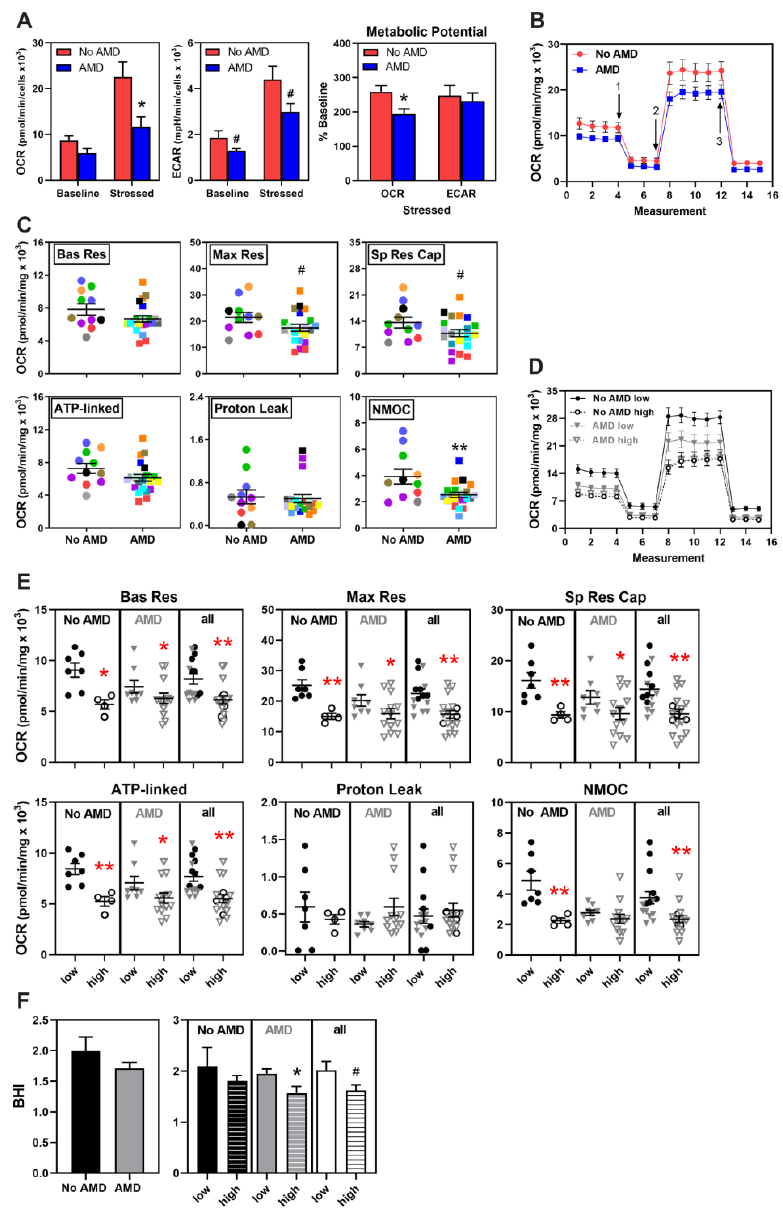
Figure 2. Metabolic dysfunction in AMD and high-risk iPSC-RPE. ( A ) Results from Cell Energy Phenotype Test of iPSC-RPE from No AMD ( n = 4) and AMD ( n = 6) donors shows the baseline and stressed OCR and ECAR. Metabolic Potential (in percent) was calculated from the change in OCR and ECAR. ( B ) Trace from the Cell Mito Stress Test (CMST) of OCR for iPSC-RPE derived from No AMD (8 donors, 11 lines) and AMD (15 donors, 21 lines) donors. Arrows indicate injection of oligomycin (1), FCCP (2), and antimycin A plus rotenone (3). ( C ) Parameters of mitochondrial function were calculated from data shown in B. Lines from the same donor are shown by the matched color symbols. ( D ) Trace from CMST assay showing OCR for iPSC-RPE from CFH low-risk (closed symbols, No AMD 5 donors, 7 lines; AMD 5 donors, 8 lines) and high-risk (open symbols, No AMD 3 donors, 4 lines; AMD 7 donors, 13 lines) donors. ( E ) Parameters of mitochondrial function calculated from data shown in D. Black symbols = No AMD, Grey symbols =AMD. Bas Res = Basal Respiration; Max Res = Maximal Respiration; Sp Res Cap = Spare Respiratory Capacity; ATP-linked = ATP-linked respiration; NMOC = Non-Mitochondrial Oxygen Consumption. ( F ) Bioenergetic Health Index (BHI) was calculated using the data from C and E. Unpaired t-tests were used to determine statistical significance in ( A , C , E , F ). Data are mean ± SEM. * p < 0.05, ** p < 0.01, # p = 0.1 is considered a trend. All other comparisons were not statistically different. See Figure S1 for a graphical description of assays in A and B.